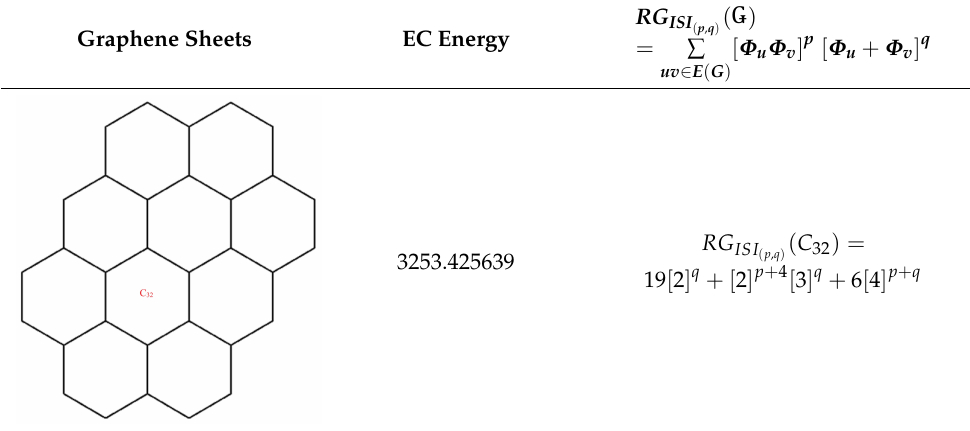
Table 1. Some reverse degree-based topological descriptors derived from the reverse general in- verse sum indeg